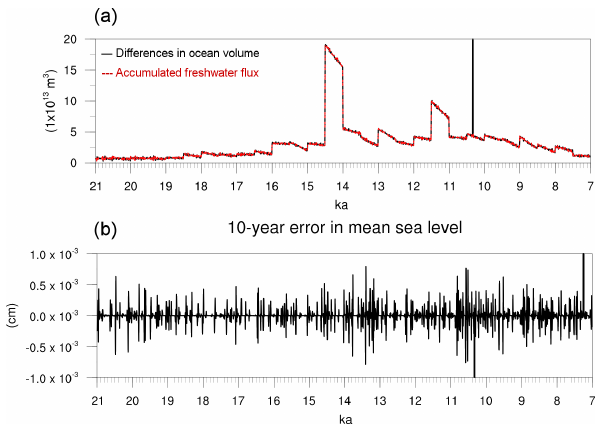
Figure 9. Time series of (a) the 10-year differences in ocean volume (m 3 ) derived from two consecutive restart files (black line) and 10- year accumulated freshwater fluxes into the ocean (m 3 , red line); and (b) difference (cm) between both divided by the ocean area during the test run with